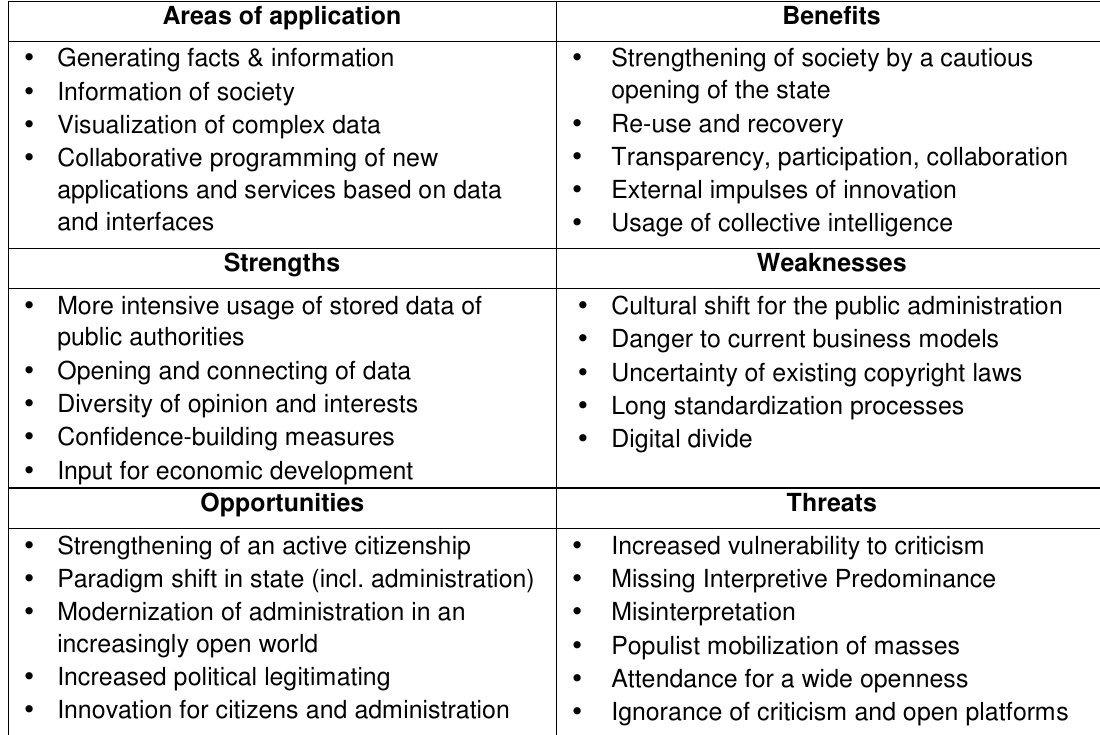
Table 2: SWOT-Analysis of Open Government Data Areas of application